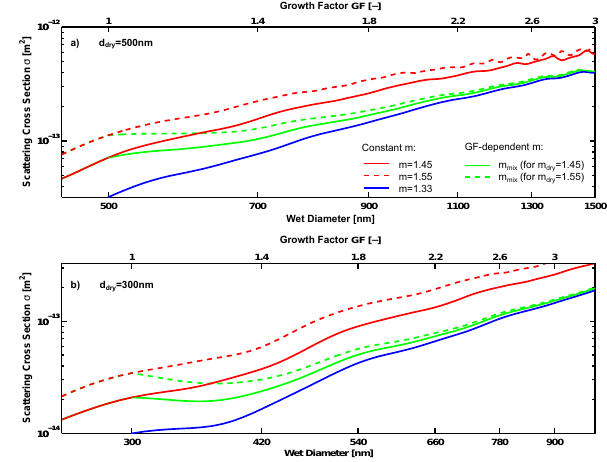
Figure 3. Schematic of the approach applied to analyze the WHOPS measurements, indicated with the violet rhombi, which can be di- vided into three main steps: first (blue dashed box), a 3-D lookup table containing σ wet as a function of D dry , m dry and GF is pre- pared using Mie theory. Second (red dashed box), the results from the dry-mode WHOPS measurements are used to infer the effective index of refraction ( m dry, meas ) of the dry particles. Third (green dashed box), the scattering cross sections σ wet, meas of the humid- ified particles measured in the wet WHOPS mode are converted to corresponding growth factors (GF meas ).